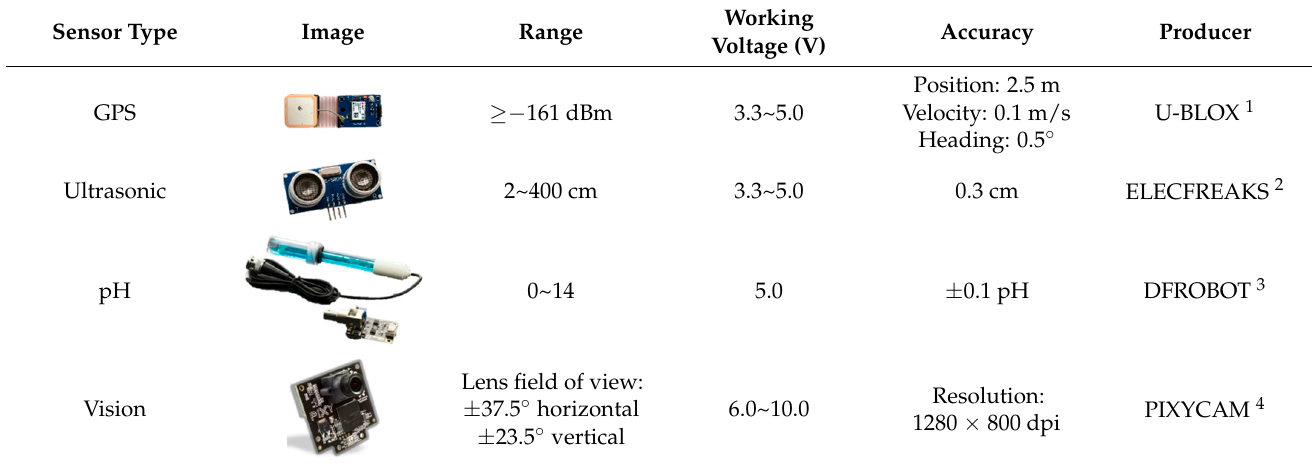
Table 3. Parameters of sensors mounted on the MF-USV.